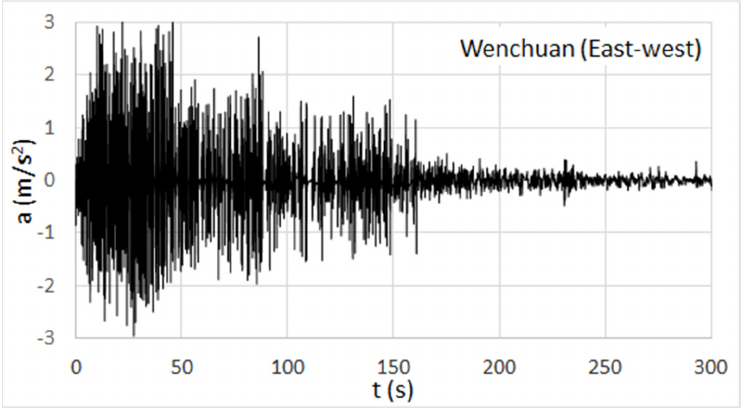
Figure 10. Time series of the seismic acceleration of the 2008 Wenchuan earthquake. (East-west component).